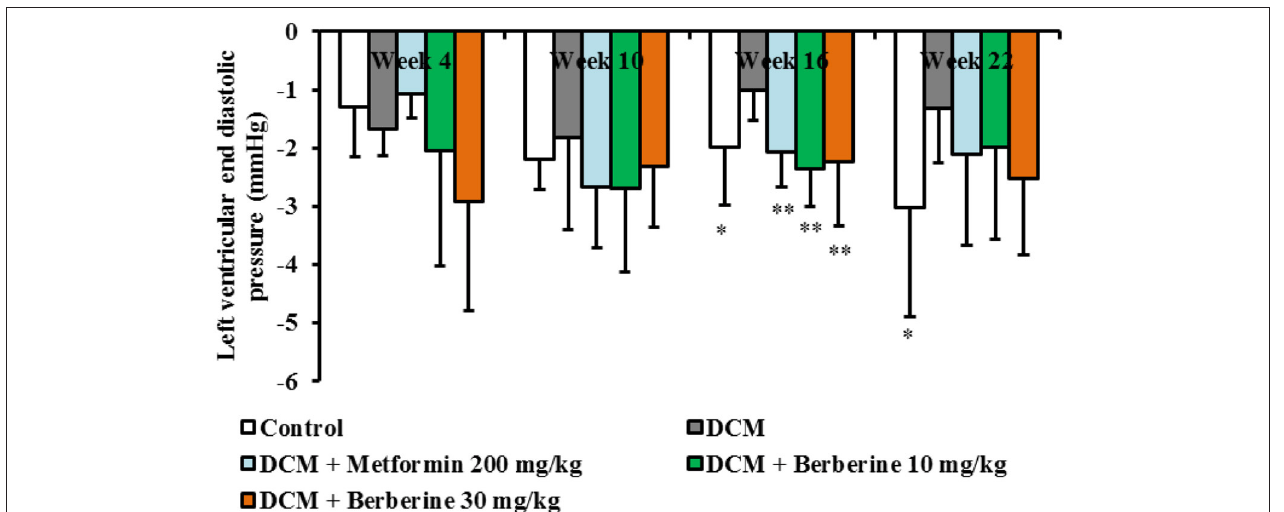
FIGURE 1 | Berberine improved cardiac diastolic function in DCM rats. Diabetic cardiomyopathy (DCM) model rats were established by feeding with high-sucrose and high-fat diet (HSHFD) consisting of regular diet (66.5%), lard (10%), sucrose (20%), cholesterol (2.5%), and bile salt (1%) and intraperitoneally (i.p.) injected with 30 mg/kg of streptozotocin (STZ) at the fifth week. Seventy-two hours after STZ injection, berberine at the dosage of 10, 30 mg/kg, and metformin at 200 mg/kg were orally given to DCM rats, respectively, for consecutive 4, 10, 16, and 22 weeks. The dynamic changes of cardiac function were measured by invasive left ventricular catheterization in anesthetized rats. DCM, diabetic cardiomyopathy. Data were shown as mean ± SD, with n = 7 ∼ 12. Statistical significance was determined by one-way analysis of variance (ANOVA) followed by least significant difference (LSD) post-hoc test. * P < 0.05, ** P < 0.01 vs. DCM group.